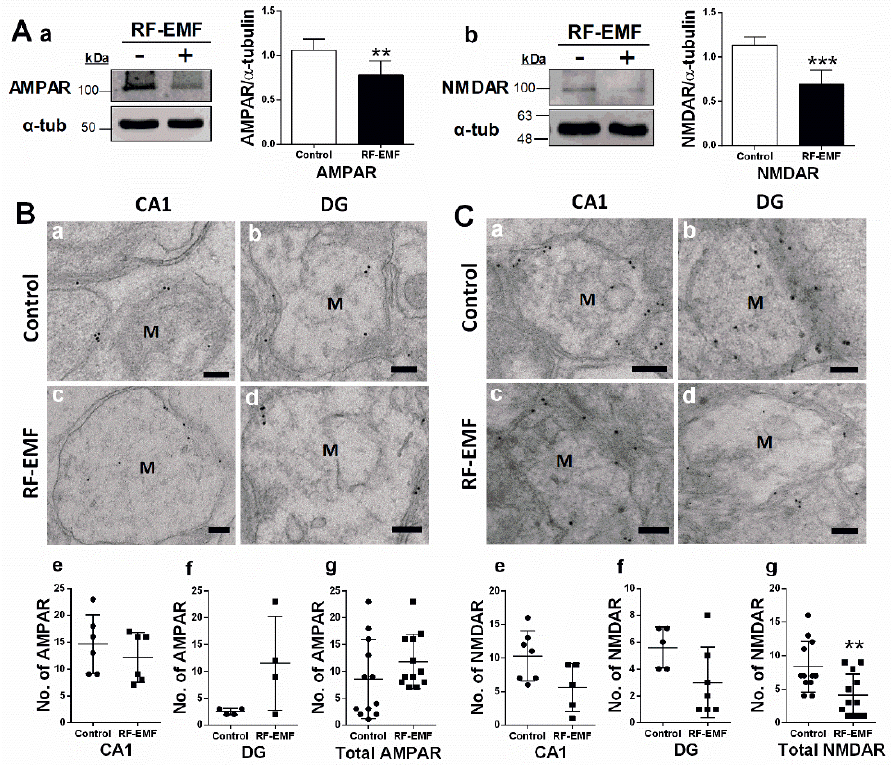
Figure 2. Expression levels of AMPAR and NMDAR in the hippocampus of RF-EMF-exposed early postnatal mice. ( A ). Protein expression levels of AMPAR (control n = 7 mice, RF-EMF n = 7 mice) and NMDAR (control n = 6 mice, RF-EMF n = 6 mice) in mouse hippocampus. Total protein was immunoblotted with antibodies against AMPAR ( a ) and NMDAR ( b ). The intensities of bands were quantified by densitometry. Protein levels were normalized relative to α -tubulin. ( B , C ). Representative immunogold staining for glutamate receptors, AMPAR ( B ) and NMDAR ( C ), in dendritic spines of hippocampal CA1 ( a , c ) and DG ( b , d ) in control ( a , b ) and RF-EMF-exposed mice ( c , d ). Gold particles labeling AMPAR and NMDAR were observed by transmission electron microscopy. The total number of gold particles labeling AMPAR (Bg) and NMDAR (Cg) in hippocampal CA1 ( e ) and DG ( f ) were quantified in mushroom-type dendritic spines. Data are expressed as means ± SD. Statistical significance was evaluated using the Student’s t -test. ** p < 0.01, *** p < 0.001 vs. control (control n = 4 mice, RF-EMF n = 4 mice). M, mushroom; • Control; (cid:4) RF-EMF. Scale bars = 200